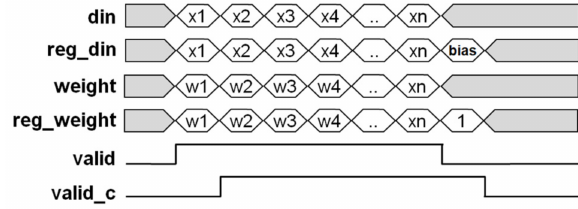
Figure 13. FC’s timing diagram.